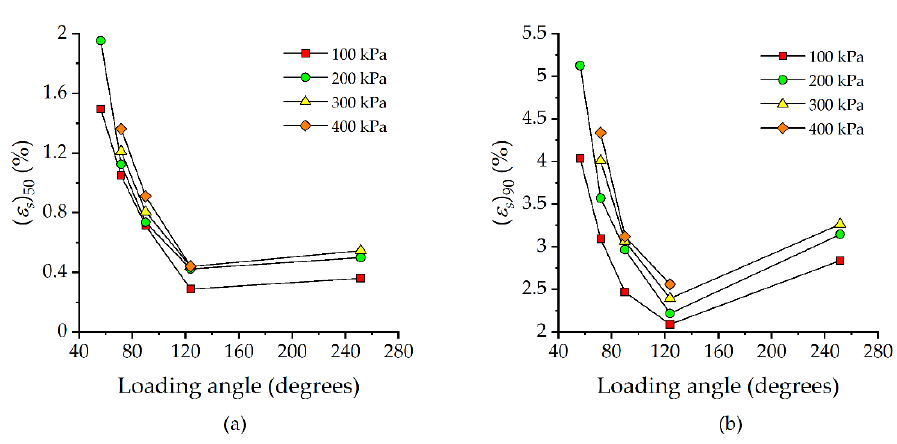
Figure 9. Variations of: ( a ) ( ε s ) 50 ; ( b ) ( ε s ) 90 with loading angle.